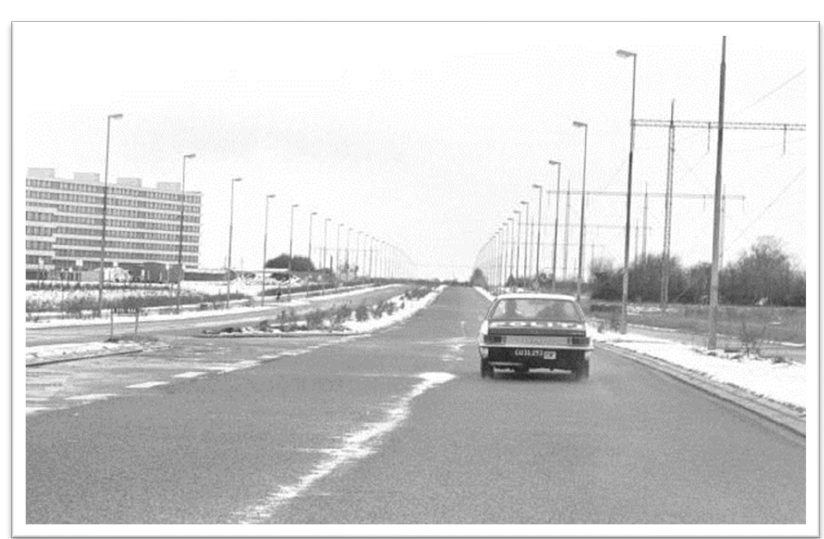
Figure 5. The energy crisis. Sundays without cars. Source: [55].